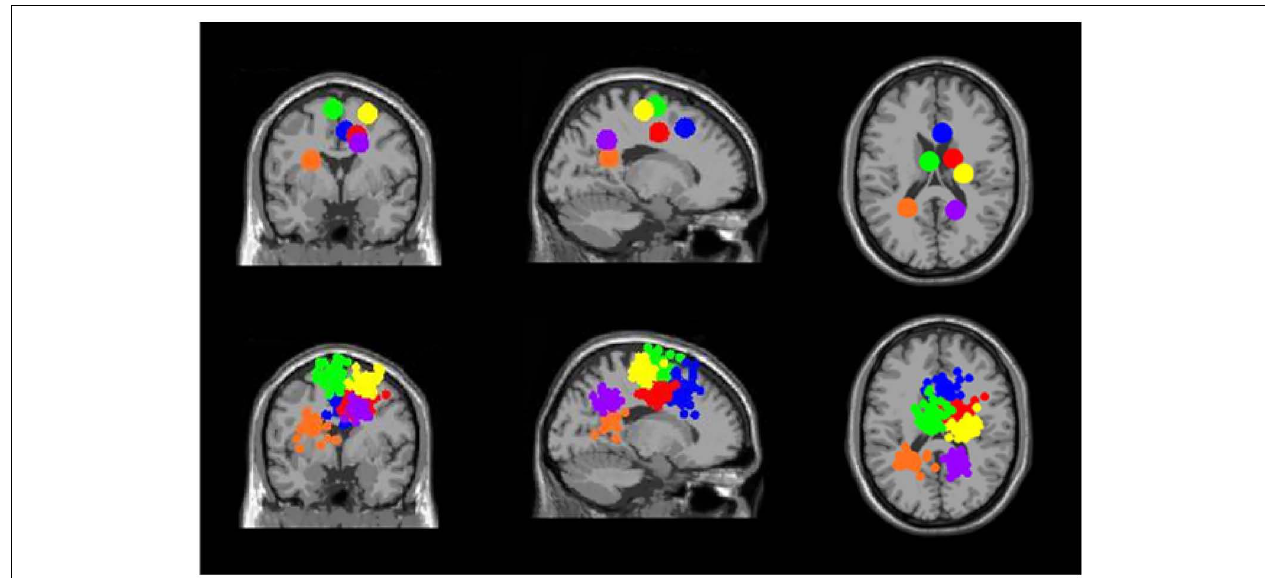
FIGURE 11 | Clusters containing electrocortical sources from > 10 subjects but without significant spectral shifts time-locked to stimulus presentation during the Brooks spatial working memory task. Green is left premotor and supplementary motor cortex (BA 6), yellow is right premotor and supplementary motor cortex (BA 6), blue is right anterior cingulate (BA 32), red is right anterior cingulate (BA